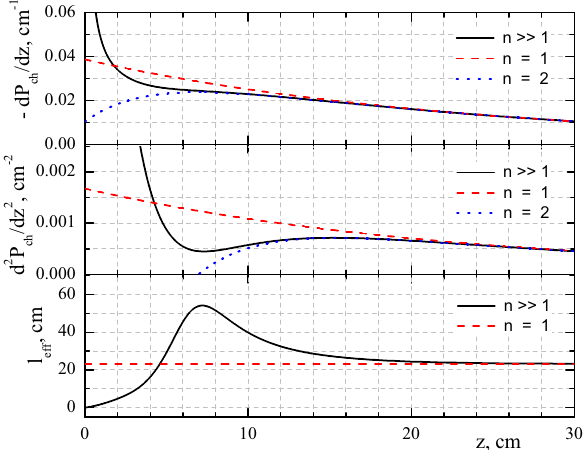
Fig. 7 Dechannelingrate(38),itsderivative(39)andeffectivedechan- neling length (40) versus crystal depth